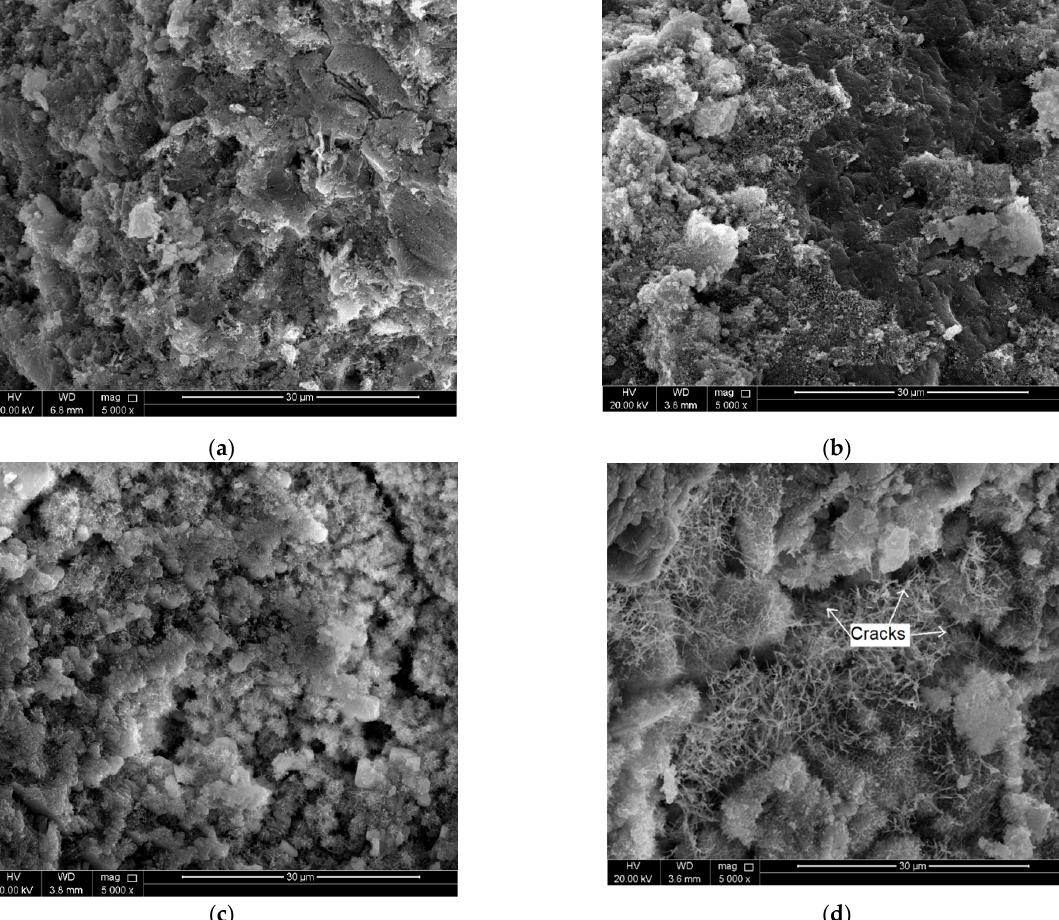
Figure 3. SEM images show the microstructure of mortar with CNTs at ( a ) RT; ( b ) 200 ◦ C; ( c ) 450 ◦ C; ( d ) 600 ◦ C.